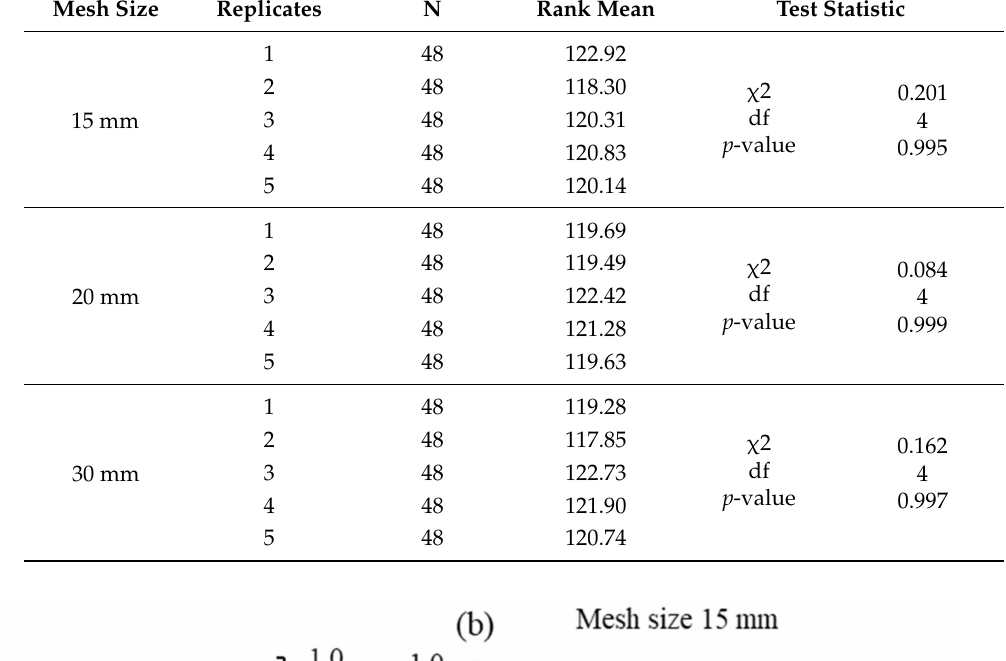
Table 2. Kruskal–Wallis results on the differences of the abundances of captured krill within replicates. N represents the total number of the respective size class of krill with a different angle given per mesh size (i.e., 15 mm, 20 mm and 30 mm).